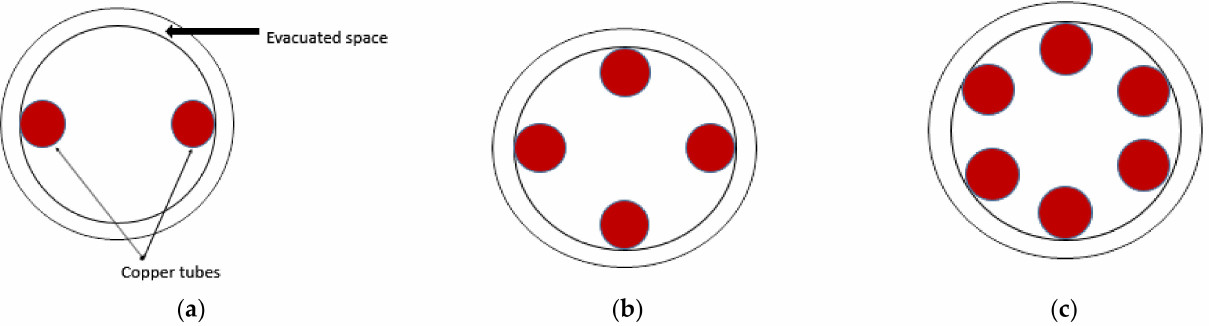
Figure 11. Different configurations of U-tube-type solar collectors [38]. ( a ) Single U-tube. ( b ) Double U-tube. ( c ) Three